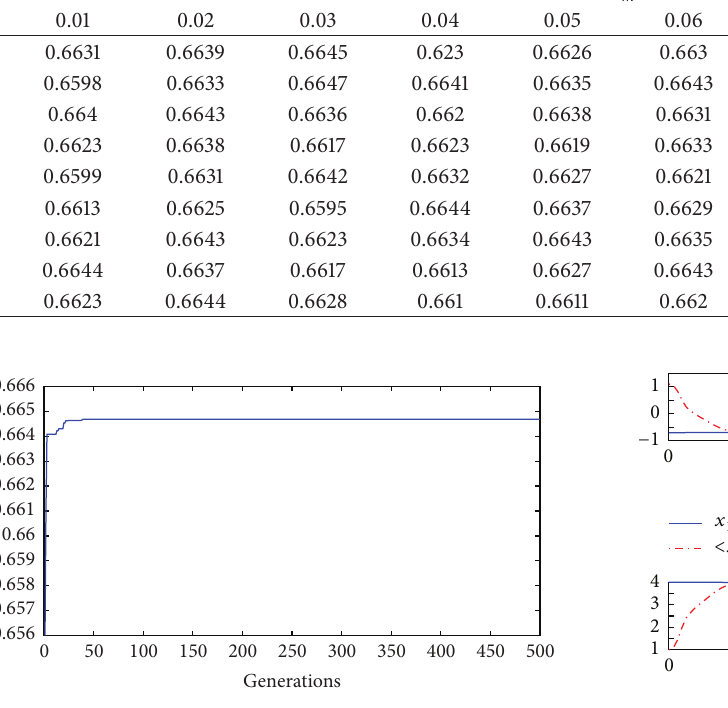
Figure 9: Fitness value of IGA.